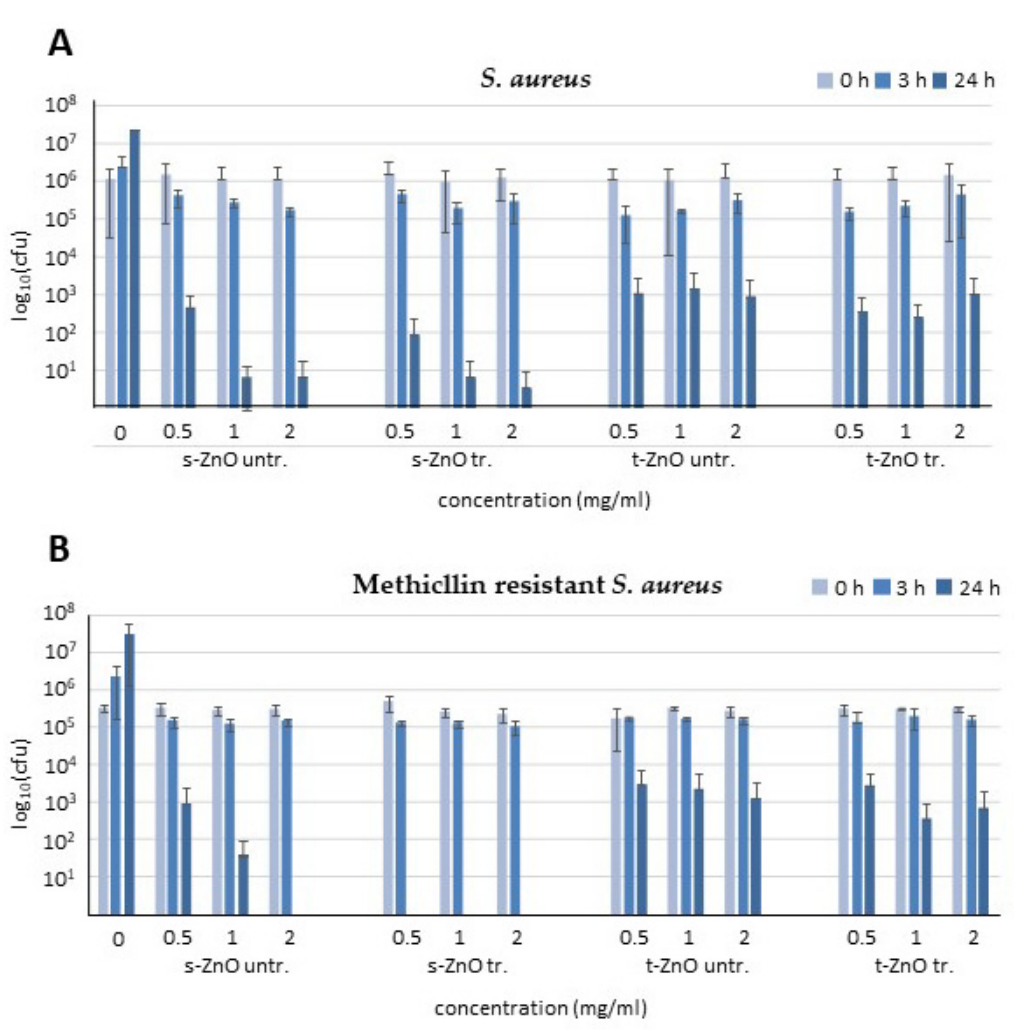
Figure 3. Antibacterial efficacy testing of untreated s-ZnO particles (s-ZnO untr.), methylene blue- treated particles (s-ZnO tr.), untreated ZnO tetrapods (t-ZnO untr.), and methylene blue-treated ZnO tetrapods (t-ZnO tr.) against ( A ) Staphylococcus ( S. ) aureus and ( B ) methicillin-resistant S. aureus (MRSA). Data are presented as mean values from three independent experiments ( n = 3) with standard deviations. Drug concentrations are shown in mg/mL. cfu = colony forming units.